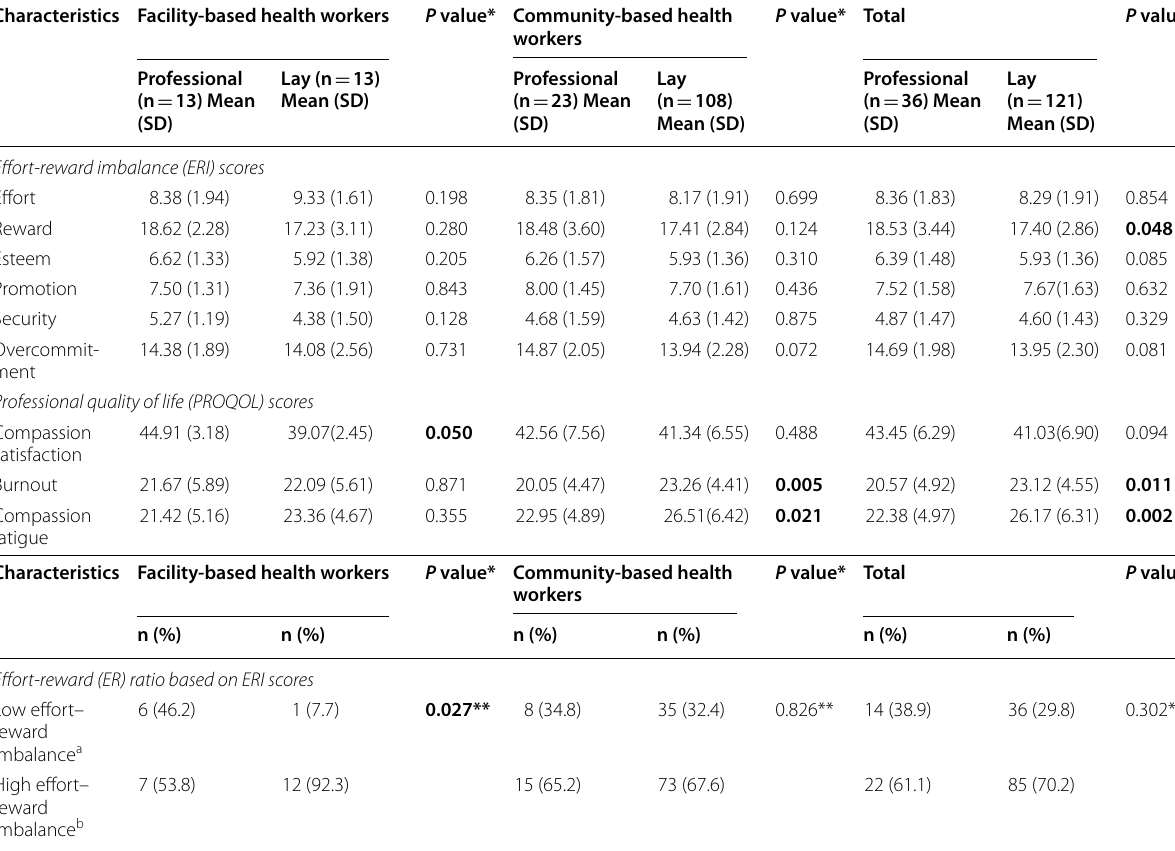
Values in bold indicate statistically significant results * T-test for continuous variables ** Chi-squared test for categorical variables a Low effort–reward imbalance—ratio of effort versus reward < 1 b High effort–reward imbalance—ratio of effort versus reward score > 1